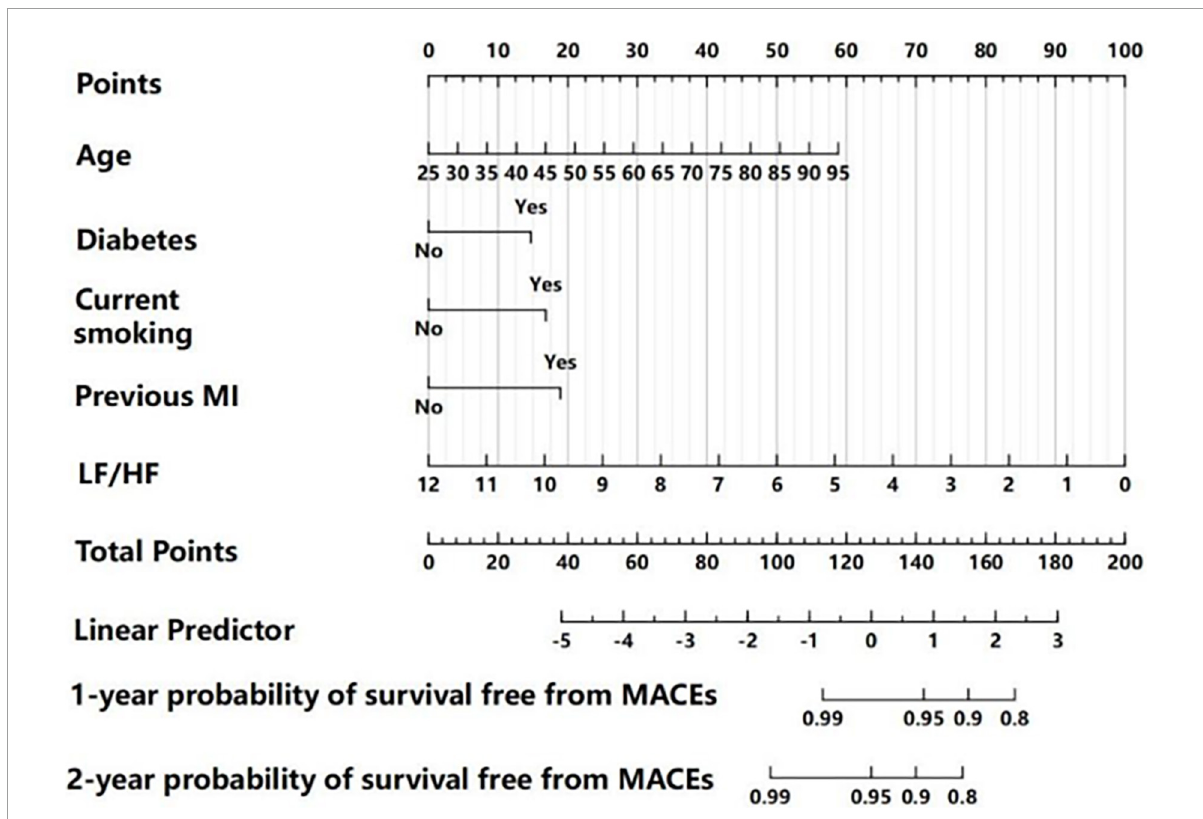
FIGURE3 Nomogram for predicting 1 and 2-year MACE-free survival, based on multivariate Cox regression analysis. For each patient, each clinical characteristic was assigned points by drawing a vertical line from its value to the top row. The points for all five characteristics were added to determine total points middle row. Then, the total points were used to determine the 1 and 2-year probabilities of MACE-free survival by drawing a vertical line to the bottom two